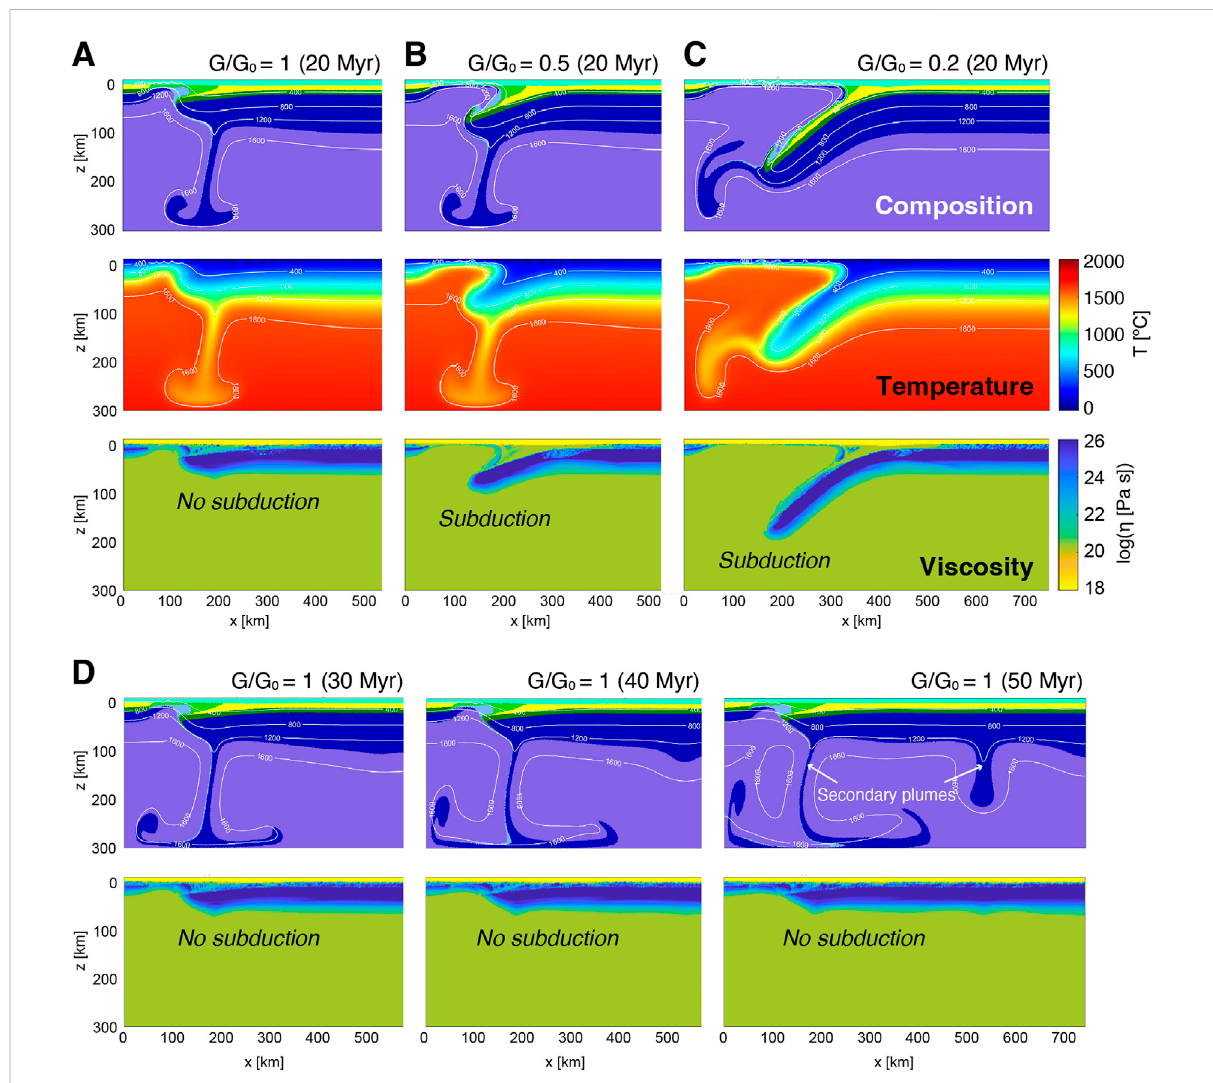
FIGURE 7 Resultsofnumericalmodelingforwetconditionwithdifferentvaluesofplaterigidity. (A – C) Snapshotofsimulationresultsusing (A) G / G 0 =1 (B) G / G G / G 0 = 0.5, and (C) 0 = 0.2 at 20 Myr after the start of the simulation. From top to bottom, the composition viscositystructureareshown.Platesubductionoccursincases (B) and (C,D) Snapshotofsimulationresultsusing G / G 0 =1 at30,40,and50Myrafter the start of the simulation. The upper mantle viscosity η um was assumed to be 2×10 20 Pa